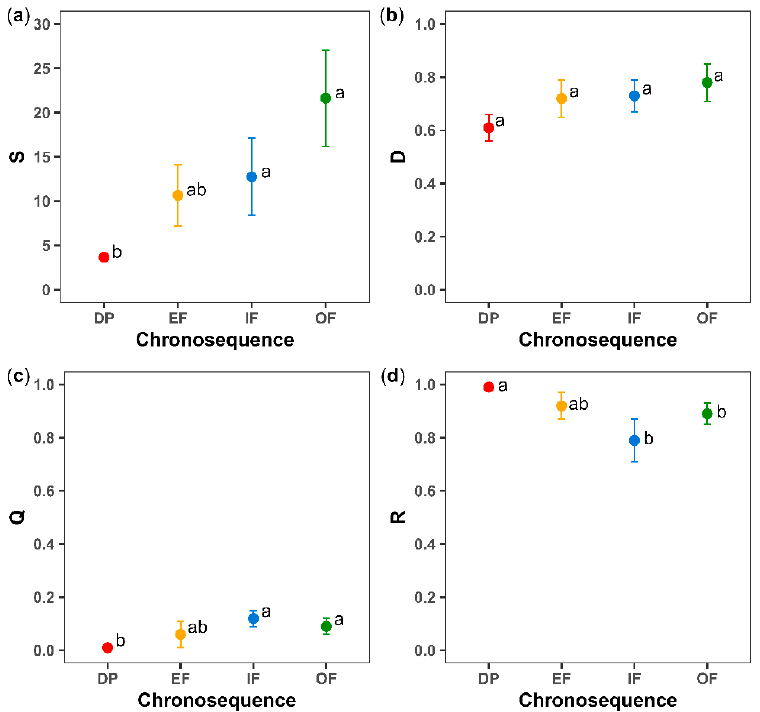
Figure 4. Means ± SE for: ( a ) species richness (S), ( b ) Gini–Simpson index (D), ( c ) Rao quadratic diversity (Q, measure of functional diversity, as well as average community-level vulnerability), and ( d ) community-level functional redundancy (R) for the different successional categories (DP, degraded pasture; EF, early forest; IF, intermediate forest; OF, old-growth forest or mature forest). For each index, values between successional categories followed by the same letter do not differ statistically according to Fisher’s LSD post hoc test ( p <